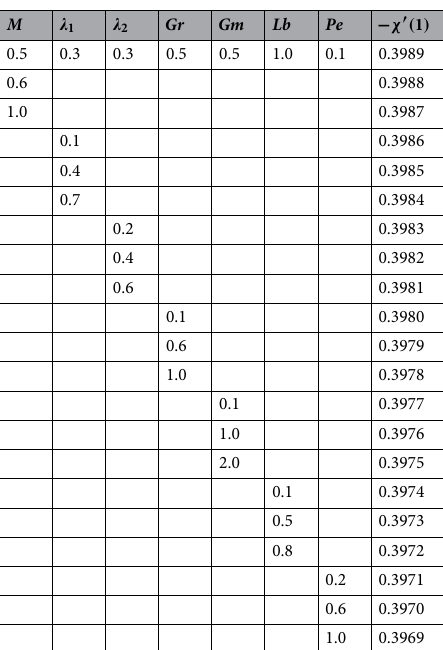
Table 5. Variation in motile microorganism density number